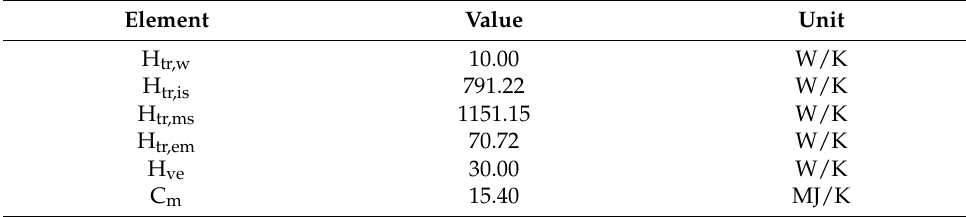
Table 1. Thermal network model elements of the building.